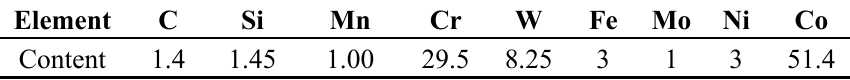
Table 2. The chemical composition of coating